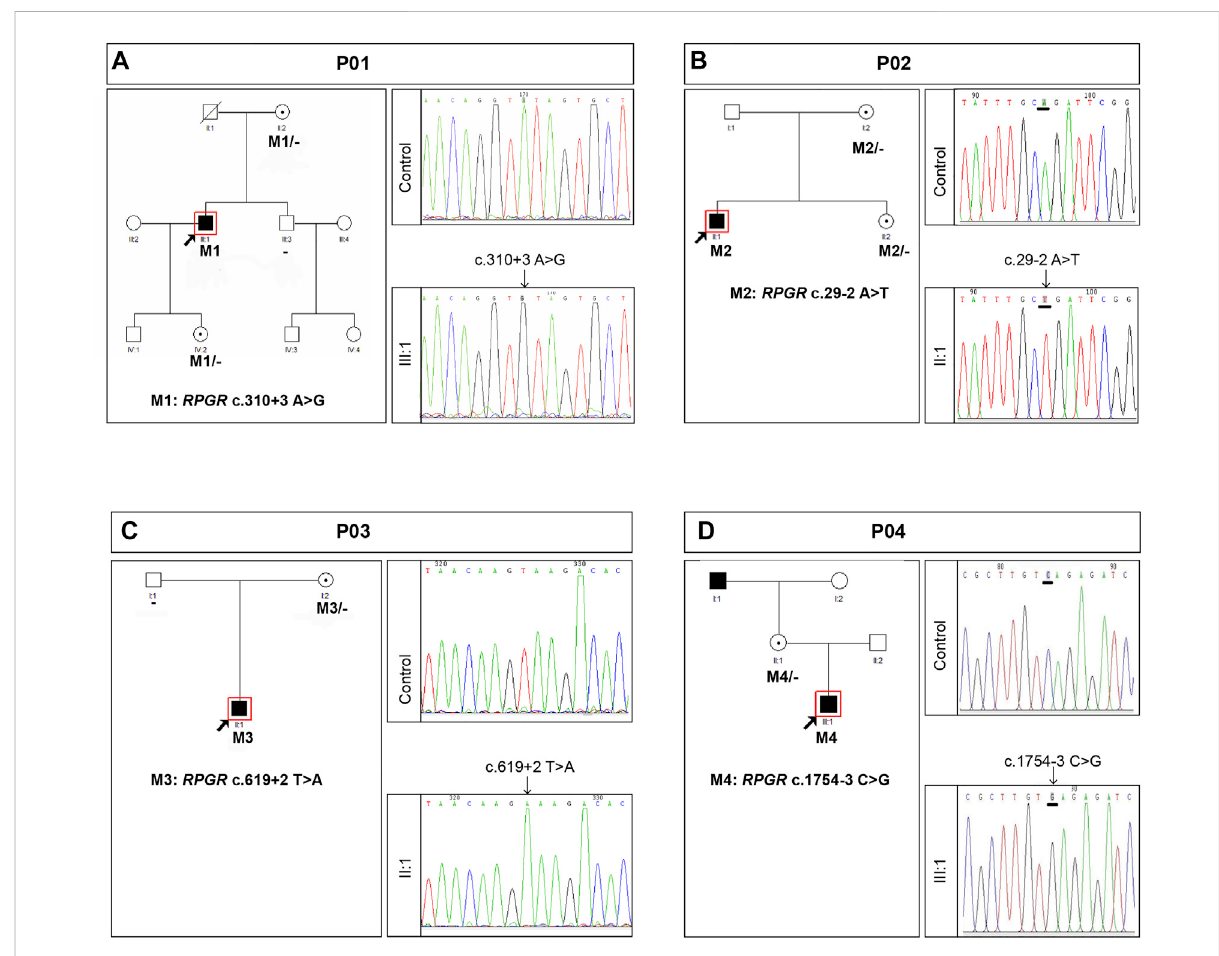
FIGURE 4 Summaryofthegenetic fi ndingsoffourpatientswithRPand RPGR intronicvariants.PedigreeandSangersequencingresultsoffamiliesP01 (A) , P02 (B) , P03 (C) , and P04 (D) . Black squares (males) and circles (females) represent individuals affected with RP. Dotted circles (females) represent individuals who are RPGR mutation carriers but who are not affected by RP. Unaffected individuals are not shaded. Black lines indicate deceased individuals. The arrow marks the